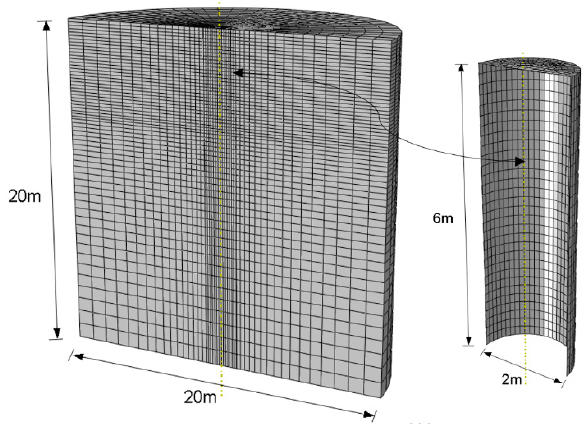
Figure 4. Three-dimensional finite element model.